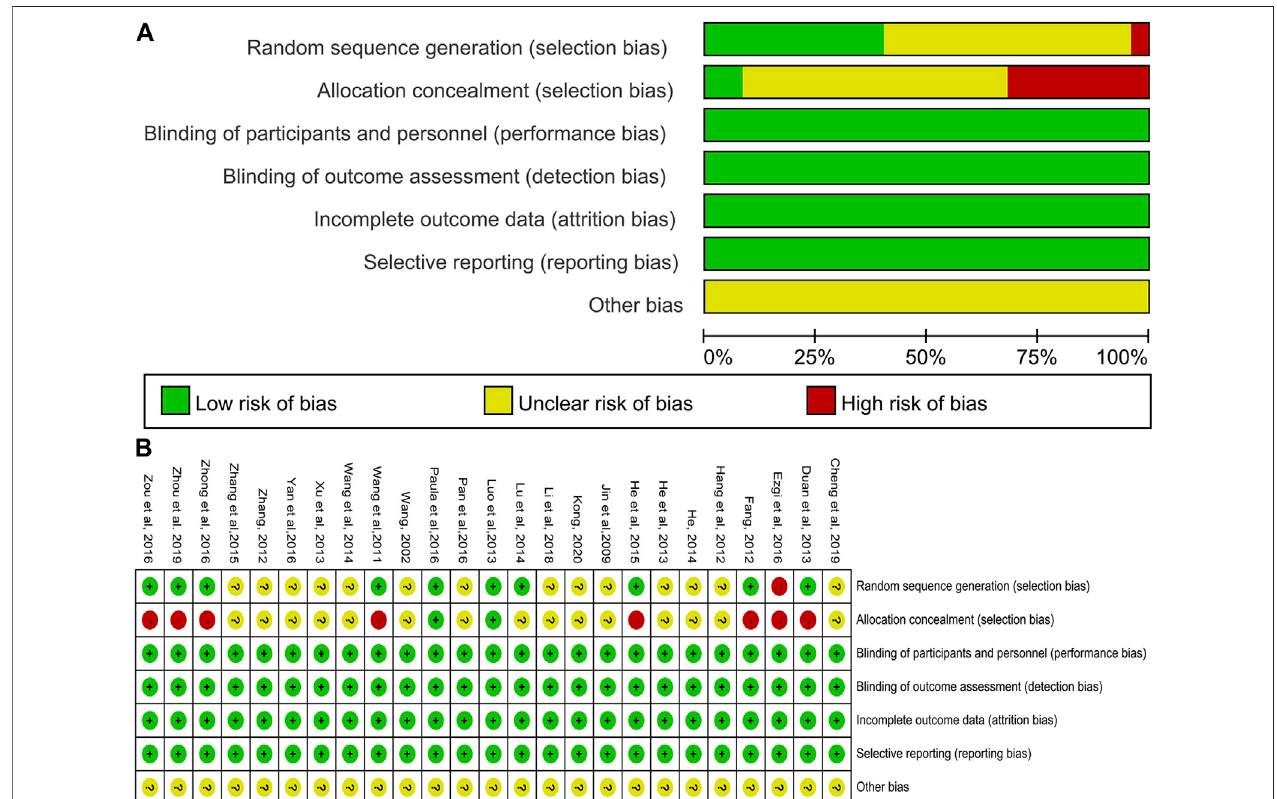
FIGURE 2 | Risk of bias of included studies. (A) Risk of bias graph; (B) Risk of bias summary.